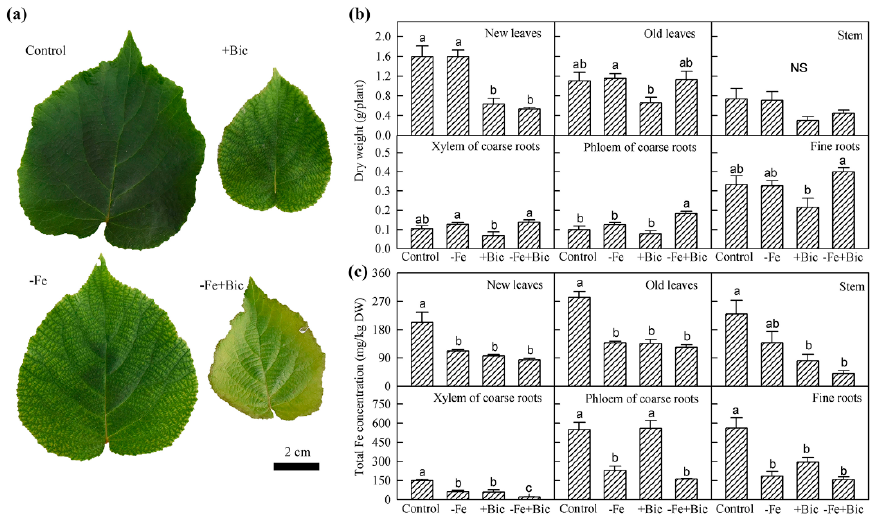
Figure 1. Leaf symptom ( a ), dry weight ( b ) and total Fe concentration ( c ) in various parts of kiwifruit plants treated with direct iron deficiency (-Fe), bicarbonate-induced iron deficiency ( + Bic) or both (-Fe + Bic) in solution culture for 28 days. Values are means of three replicates ± standard error (SE). Different letters indicate significant differences among the treatments for the same plant part at P < 0.05. DW, dry weight; NS, not significant. Table 1. The concentration and distribution of 57 Fe derived from nutrient solution ( 57 Fedfs) in new leaves, old leaves, stem, xylem of coarse roots, phloem of coarse roots, and fine roots of kiwifruit plants treated with -Fe, + Bic or -Fe + Bic in solution culture for 28 days. Values are means of three replicates ± SE. Different letters indicate significant differences among the treatments for the same plant part at P < 0.05. DW, dry weight.